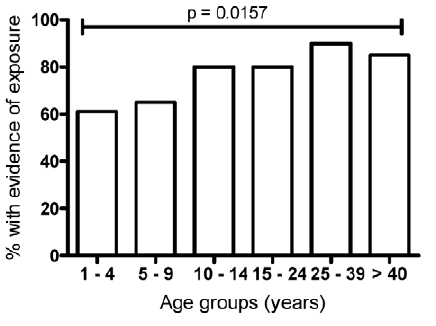
Figure 5. Evidence of malaria exposure in Brefet increases with age. The percentage of individuals showing a response above the respective cut off to at least one of the malarial antigens tested either in the ELISA or the ELISpot assays is shown, stratified according to age. Chi-squared test for trends indicated a significant increase with age